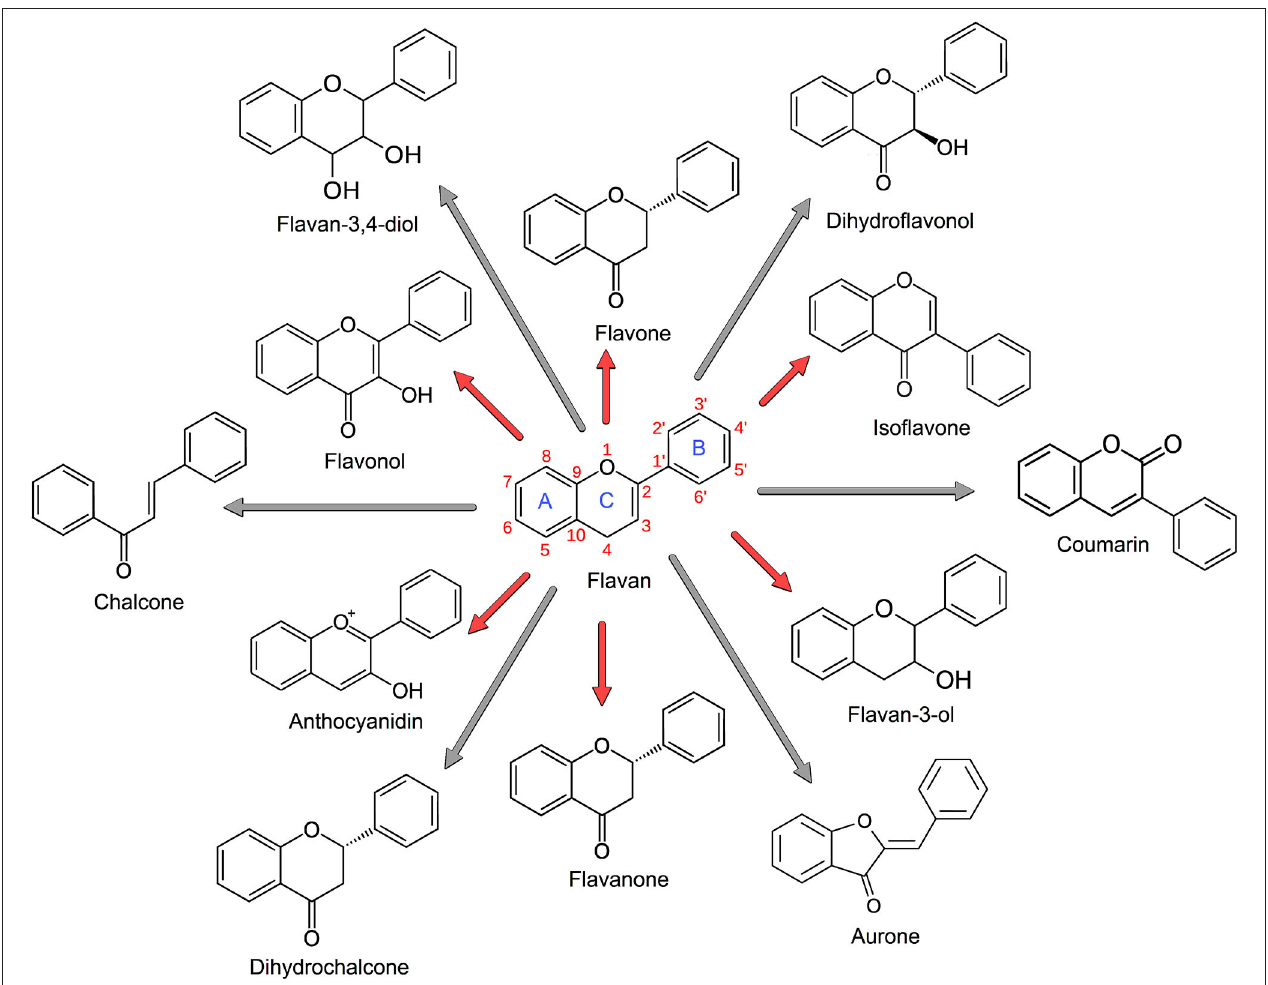
FIGURE 1 | Flavonoid nomenclature. The main subclasses of flavonoids are shown in red arrows, including anthocyanidins, flavan-3-ol, flavanones, flavones, flavonols, and isoflavones. The minor flavonoids are shown in gray arrows, including aurone, chalcone, coumarin, dihydrochalcone, dihydroflavonol, and flavan-3,4-diol. Isoflavones are characterized by having the B-ring attached at C 3 rather than the C 2 position, and coumarins follow the same structure of isoflavones, except for the double-bond oxygen that is located in C 3 , not in C 4 . Based on Hahlbrock ( 5) and Crozier et al.